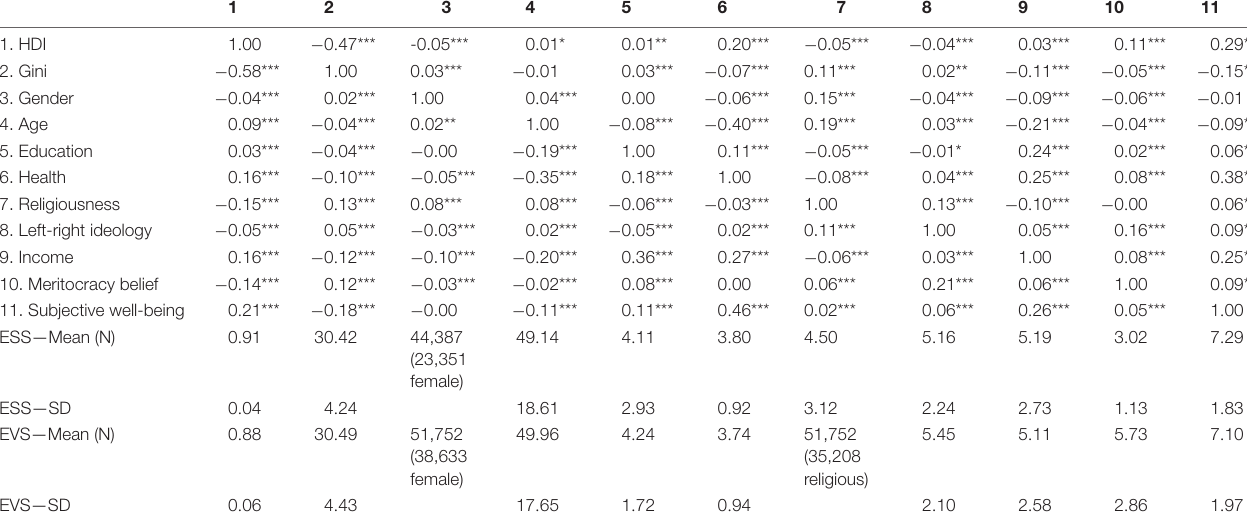
TABLE 1 | Descriptive statistics and correlations between variables based on the pooled ESS and EVS datasets.